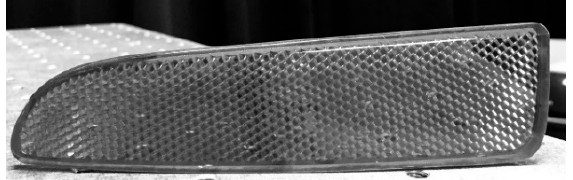
Figure 9. Commercial curved reflex reflector.